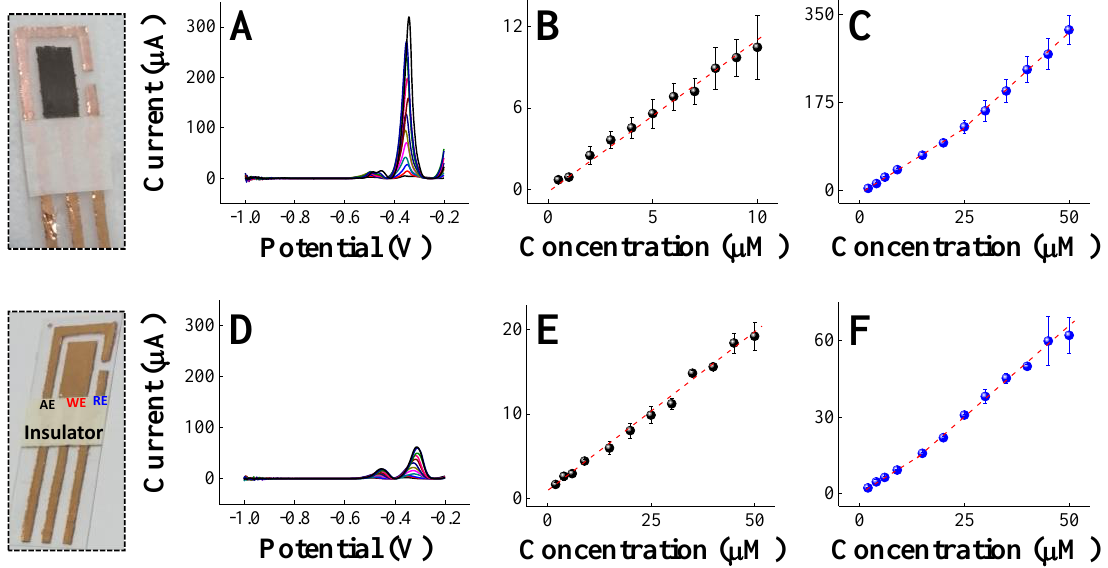
Figure 3. Differential pulse anodic stripping voltammetry in ( A ) and analytical curves for Cd 2+ in ( B ) and Pb 2+ in ( C ) obtained for flexible copper sensors decorated with bismuth mi- cro/nanodentrites. Differential pulse anodic stripping voltammetry in ( D ) and analytical curves for Cd 2+ in ( E ) and Pb 2+ in ( F ) obtained for bare flexible copper sensor. Conditions: simultaneous detection of heavy metals with the concentration varying from 2.0 µ M to 50 µ M in artificial